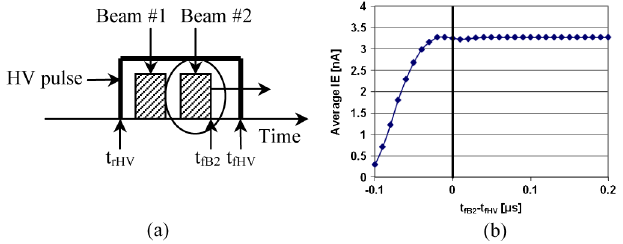
FIG. 7. (a) Pulsing diagram of the test, T B1 ¼ T B2 ¼ 0 : 1 (cid:1) s , ¼ 1 (cid:1) s , V ¼ 2 kV ; beam #1 was embedded in the HV T HV HV pulse and beam #2 swept across its falling edge in steps of 10 ns. (b) Average I E at each step. Vertical line: t rB2 ¼ t fHV . The peak emission gain was